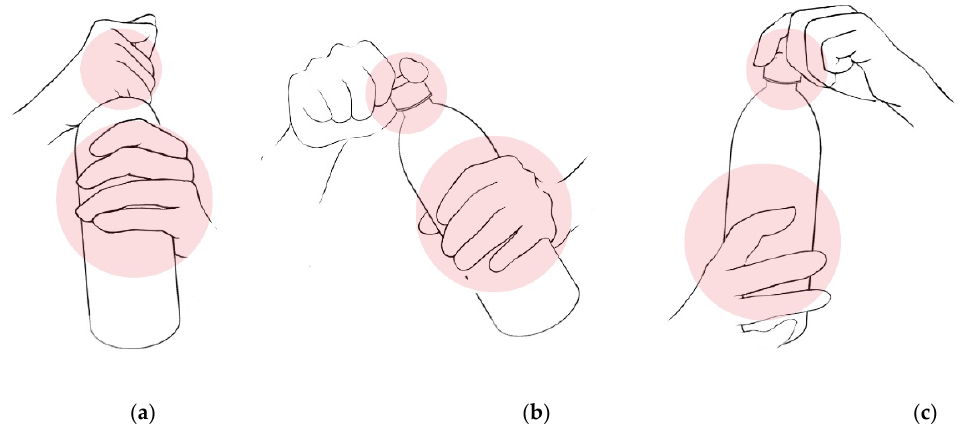
Figure 3. T wo-hand positions to open bottled water products in ordinary settings: ( a ) Holding the top of the bottle and twisting with the cylindrical pinch); ( b ) holding the centre of the bottle and twisting with the lateral grip; ( c ) holding the top of the bottle and twisting with the chuck grip.